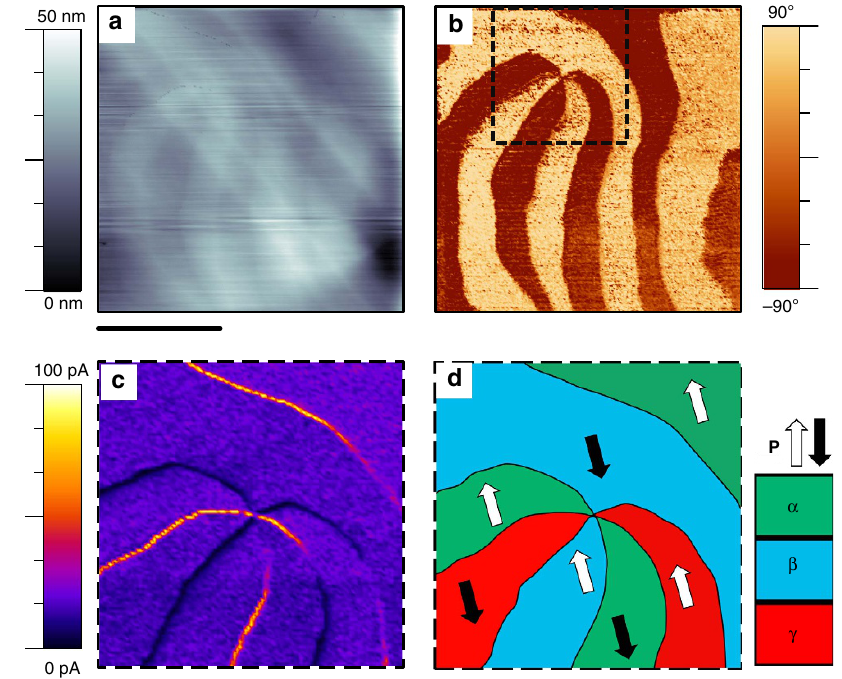
Figure 1 | Piezoresponse and conductive analysis of domain structure in YbMnO 3 . ( a ) Topographic map of a 5 (cid:2) 5 m m 2 region on an unpolished YbMnO 3 single crystal measured via contact atomic force microscopy. ( b ) Piezoresponse force microscopy map (phase information from lateral mode imaging; cantilever axis horizontal with respect to the image) and ( c ) conductive atomic force microscopy map, taken at 2.3V, of the subset area showing conduction anomalies along domain walls. ( d ) Structural schematic of the sixfold-vertex region. Taking a circular path around the central vertex it is seen that both the structural and corresponding polarization states alternate, so that no two equivalent structural or ferroelectric domains share a wall. Comparison of the polarization directions implied from b (shown in the schematic in d ) with the current map in c confirms that largest currents are measured at tail-to-tail walls. Scale bar for a , b is 2 m m and for c , d is 1 m